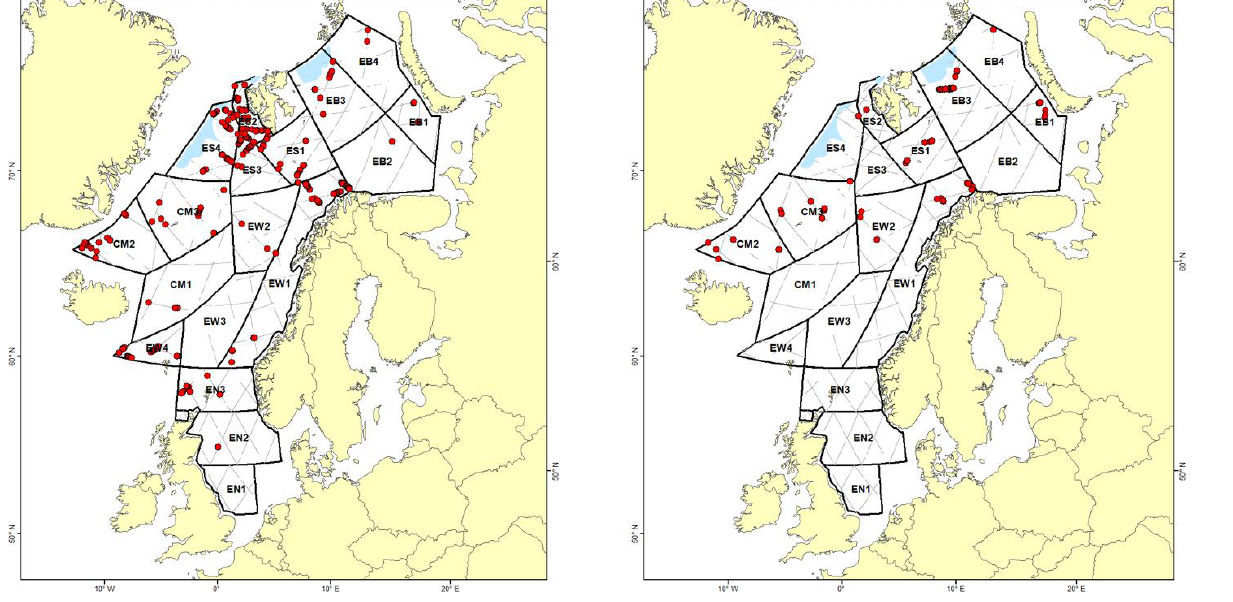
Figure 5. Distribution of sightings recorded as humpback whales during the 2014 – 2018 sighting surveys. The blue areas represent ice coverage. Sperm whales Sperm whale sightings occurred over the deep waters of the Norwegian Sea (EW2), south of Jan Mayen (CM1) (Table 8; Figure 6). The data were truncated at a perpendicular distance of 4000 m and fitted with a half-normal DS detection function, resulting in an estimated p (0)=0.69 (CV=0.15) and eshw of 1849 m. The fitted DS detection function and MR conditional detection function are shown in Figure 4c. Total corrected abundance of sperm whales was estimated to be 5,704 (CV=0.26, 95% CI: 3,374 – 9,643) (Table 8).